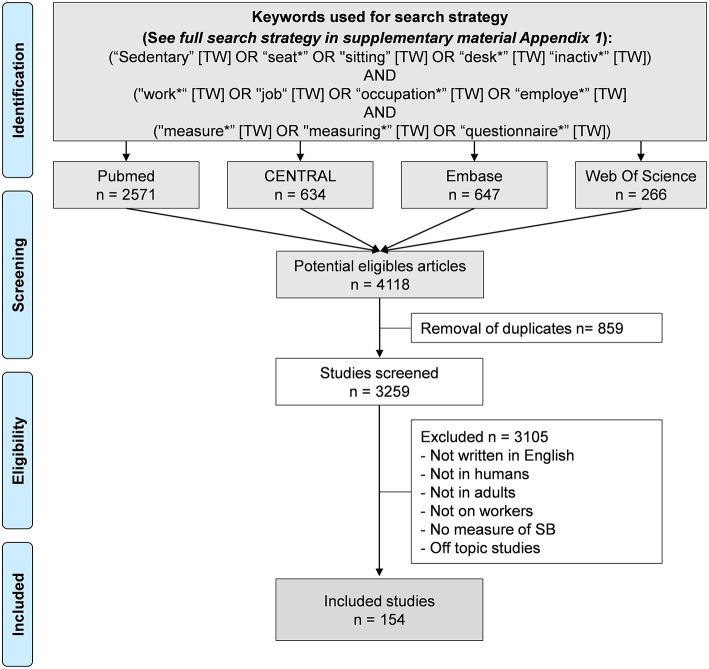
Search strategy.